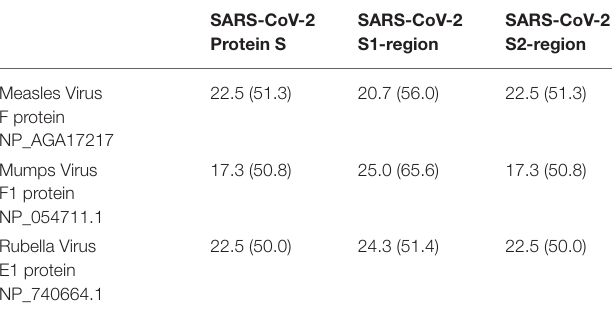
TABLE 8 | Protein S—aminoacidic identity and similarity between SARS-CoV-2S protein (YP_009724390.1) and its subregions S1 ( P0DTC2 13-685 ) and S2 ( P0DTC2 686-1237 ) [identity % (similarity %)] with measles virus F1 protein, mumps virus F1 protein, and rubella virus E1